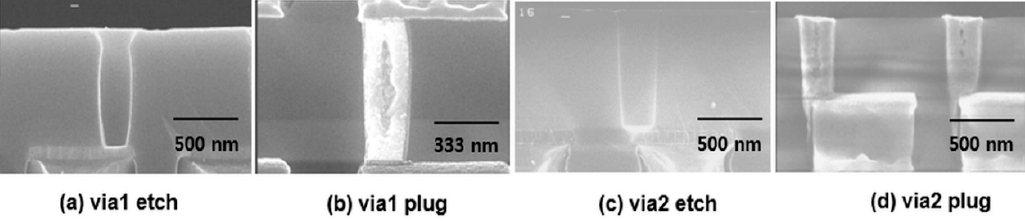
Figure 3. The cross section SEM images of after ( a ) via 1 etch, ( b ) via1 plug W filling, ( c ) via2 etch, and ( d ) via 2 plug W filling.